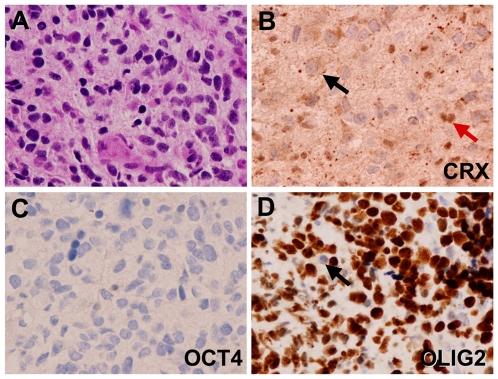
Diagnostic use of lineage-specific transcription factor “code” in evaluation of a glioblastoma of the pineal region.Examination of H&E stained sections of a pineal tumor reveals high-grade histologic features somewhat suggestive of glioblastoma (A). Immunohistochemistry showed nuclear CRX in normal pineocytes (red arrow) that are infiltrated by the invasive tumor which is negative for CRX (black arrow) (B). The germ cell marker OCT4 is absent in neoplastic cells and in pineocytes (C). However, robust expression of OLIG2 is evident in neoplastic cells but absent in infiltrated pineocytes (arrow) (D). Original magnification 400x.